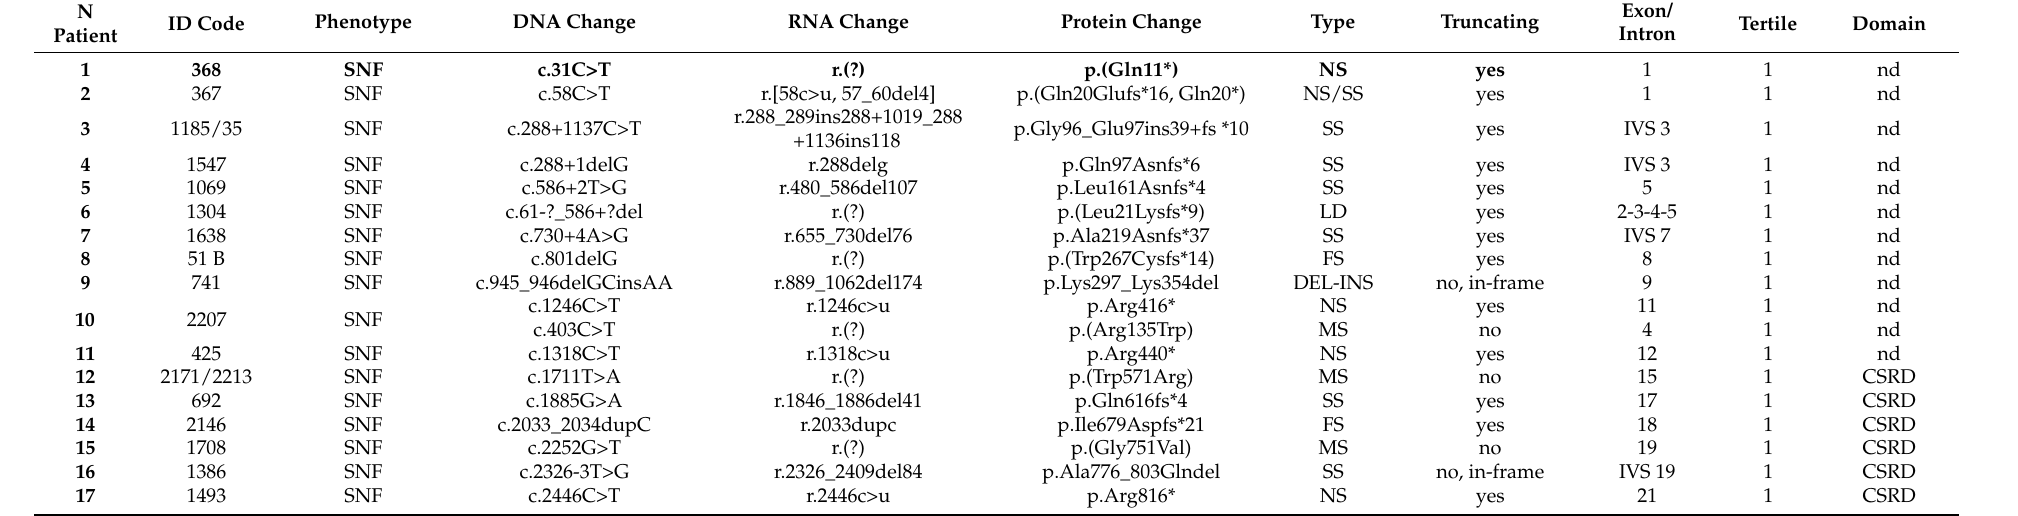
Table 4. NF1 variants observed in 55 SNF